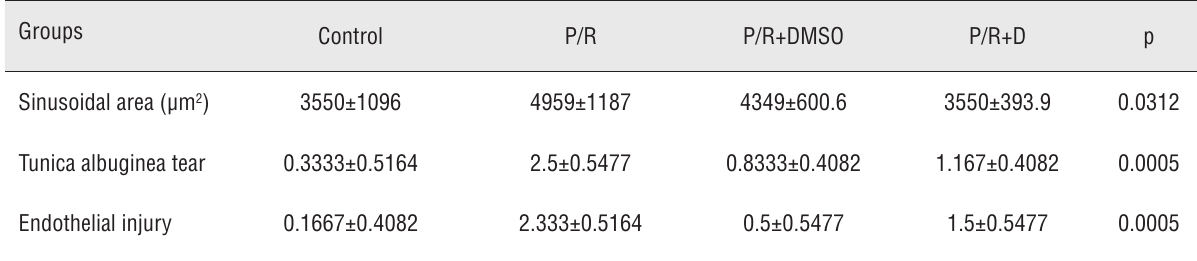
Table 1 - groups’ histological data. Groups Control